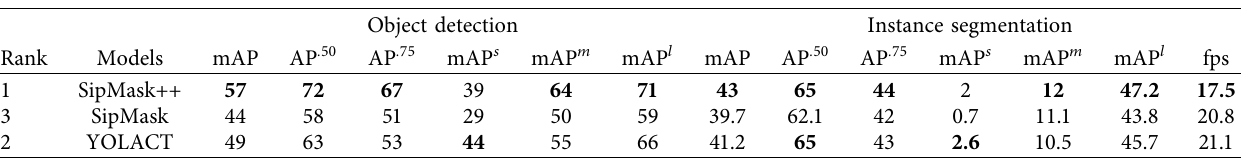
Table 3: A performance comparison ranking of SipMask++, SipMask, and YOLACT instance segmentation performance against the workshop repair dataset with merged, 22-class Dataset 2.